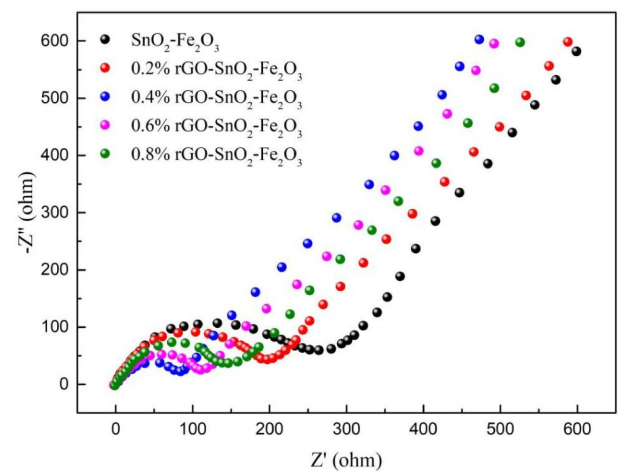
Figure 7. AC impedance diagrams of rGO-SnO 2 -Fe 2 O 3